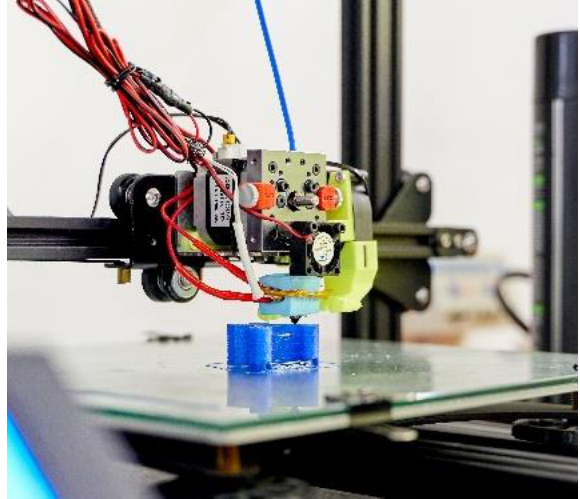
Figure 1. Adapted FDM machine to extrude flexible filaments.